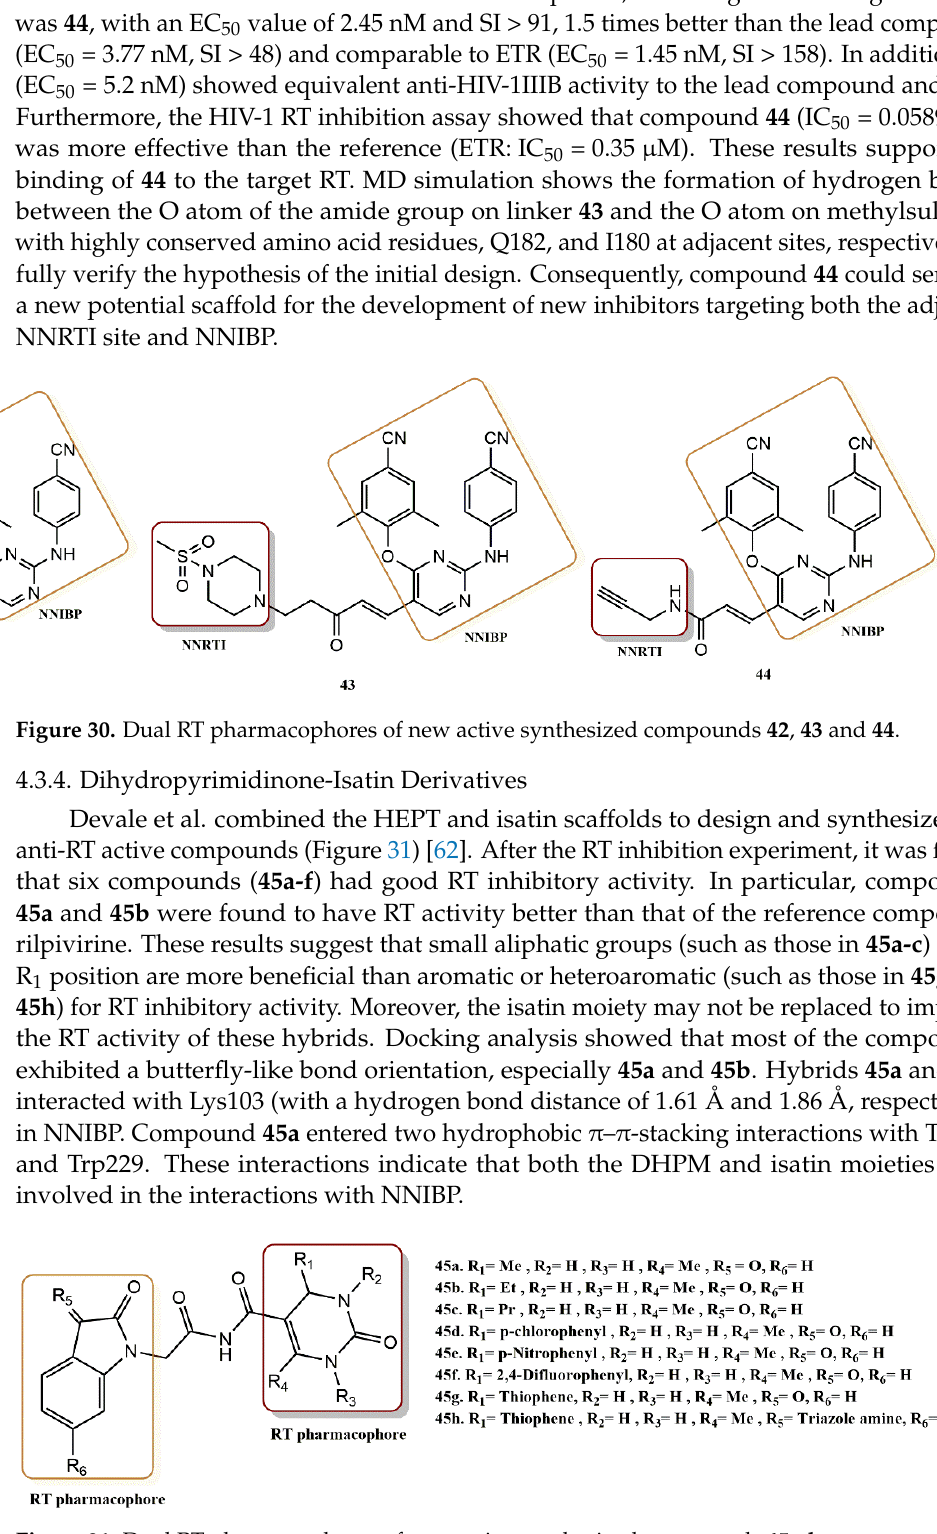
Figure 31. Dual RT pharmacophores of new active synthesized compounds 45a-h.